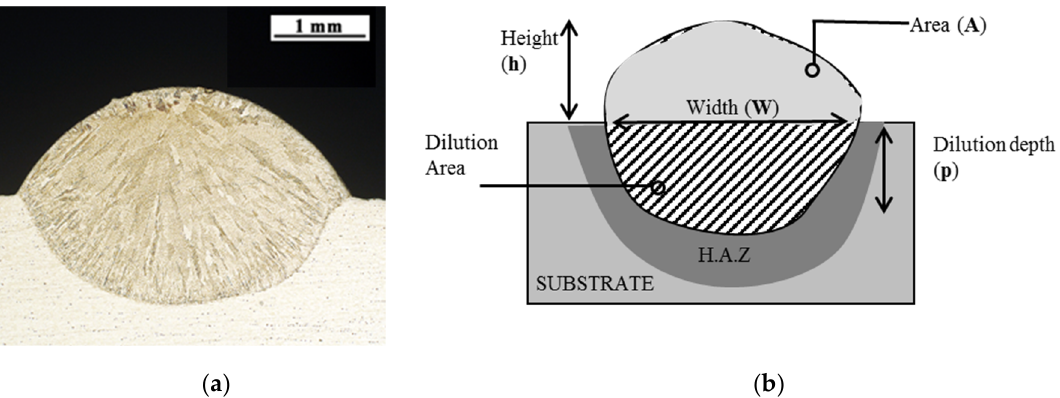
Figure 1. Single clad. ( a ) Macrophotograph of a cross section of a single clad; ( b ) scheme of the single clad characteristics.